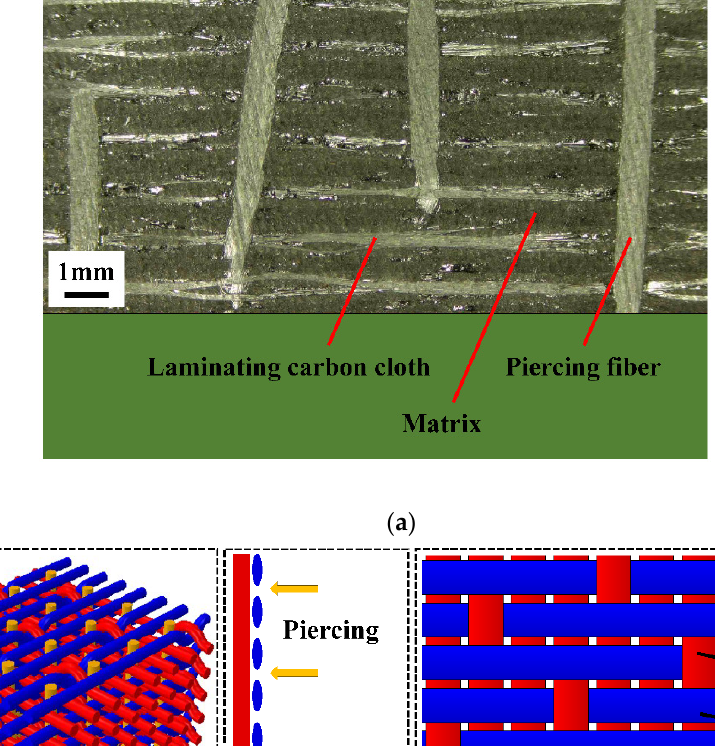
Table 1. Performance of the C/C composites at different temperatures.